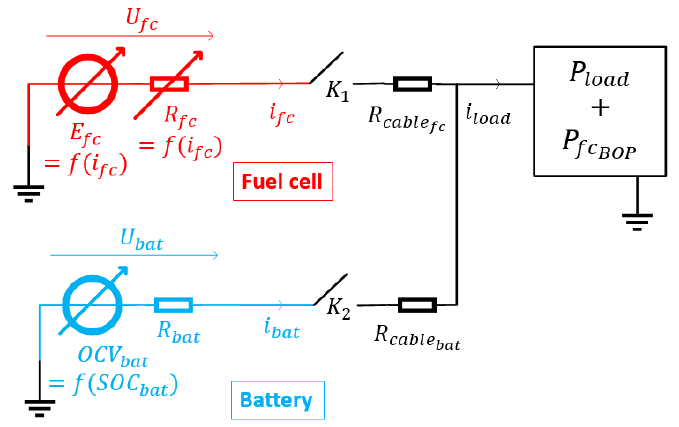
Figure 6. Equivalent electrical diagram of the simplified model of a fuel cell–Li-ion battery direct hybridization.